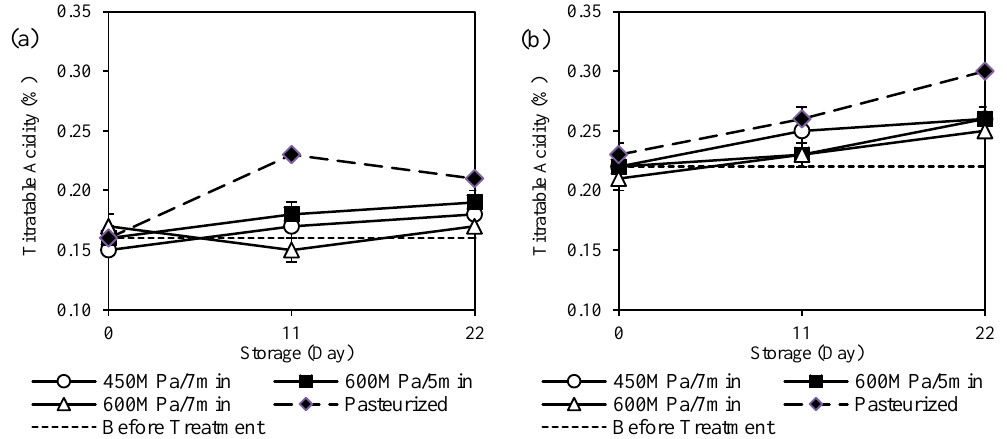
Figure 2. Changes in titratable acidity of ( a ) cow and ( b ) goat milk during storage period of 22 days. Solid lines represent HPP-treated milk (450 MPa/7 min, 600 MPa/5 min, 600 MPa/7 min), dashed lines represent pasteurized milk, and dotted lines represent fresh milk before treatment.